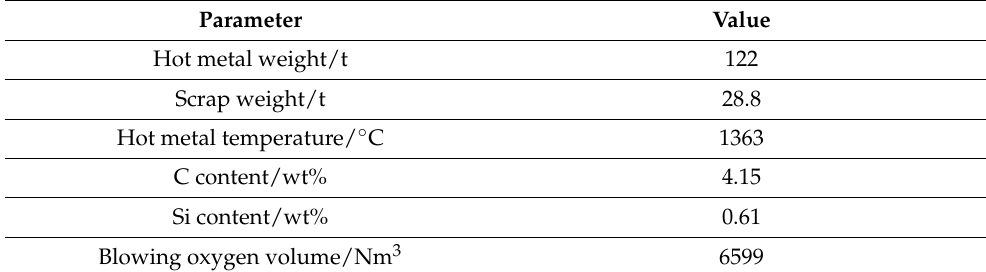
Table 4. The specific information of the production heat.